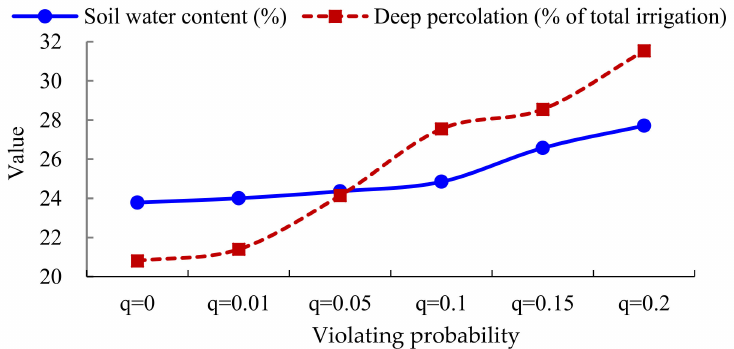
Figure 7. Changes of soil water content and deep percolation under different violating